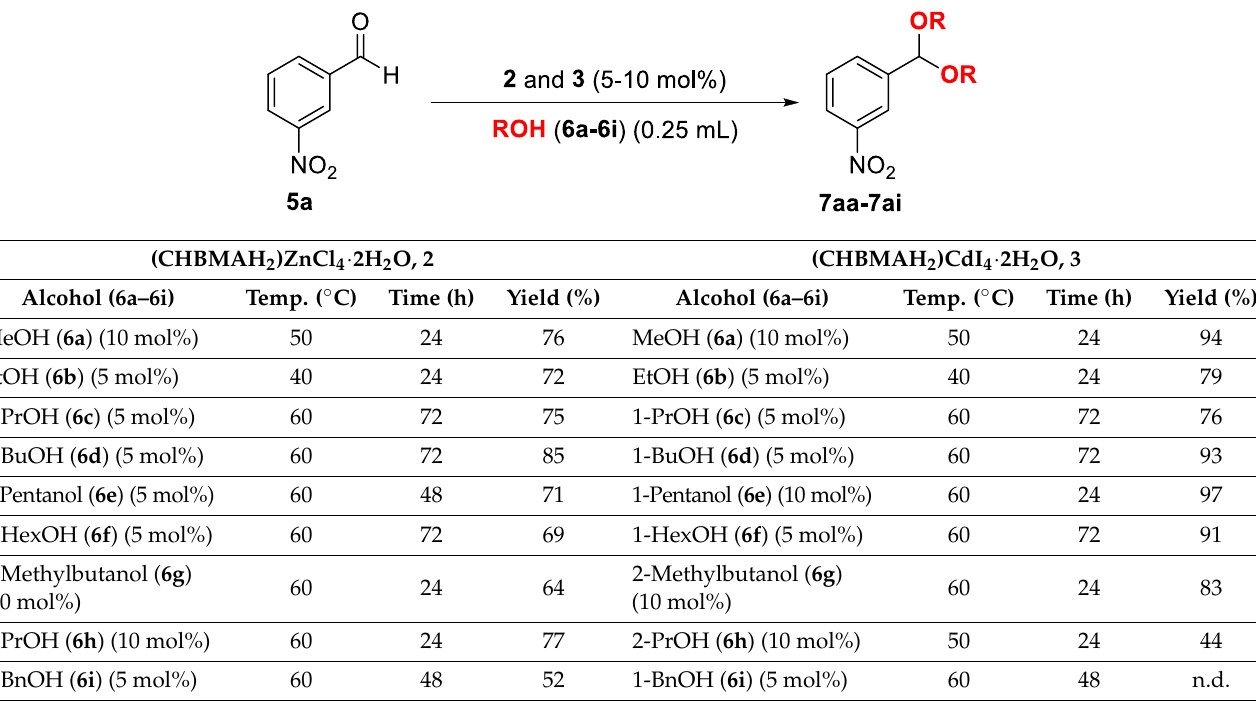
Table 5. Comparative reactivity between 2 and 3 using different alcohols as an acetylation source a .